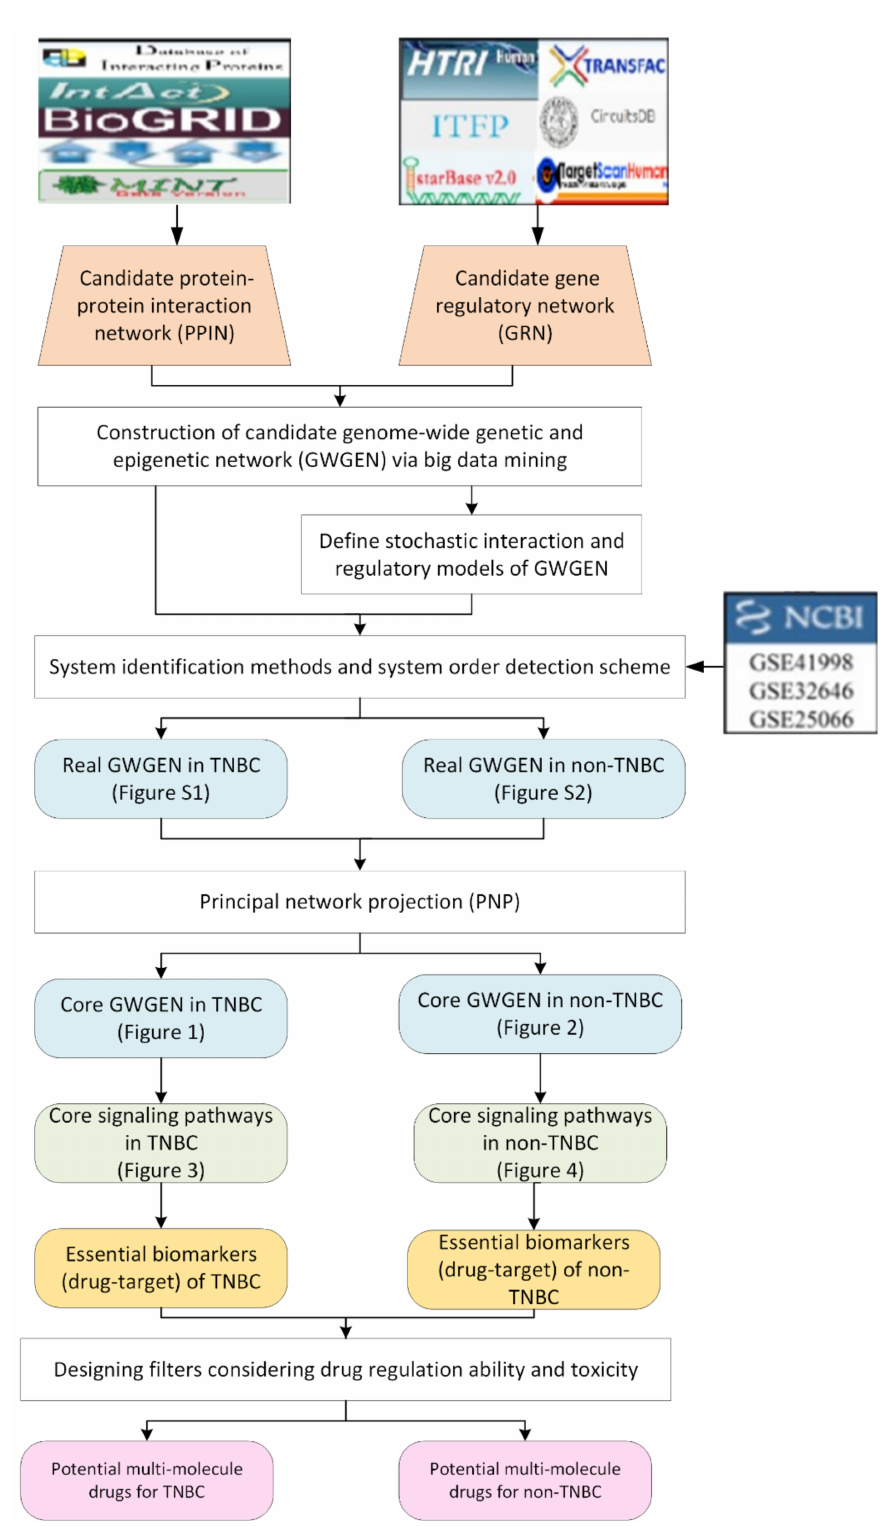
Figure 6. Flowchart of systems medicine procedure for finding essential biomarkers (drug targets) and proposing potential multi-molecule drugs for TNBC and